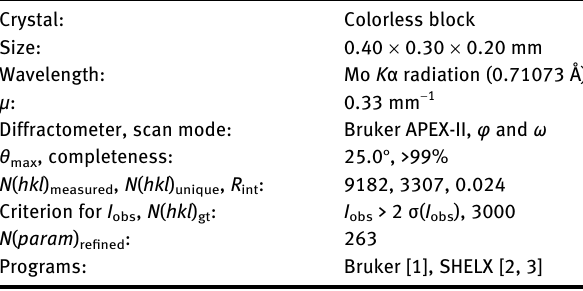
Table  : Data collection and handling. Crystal: